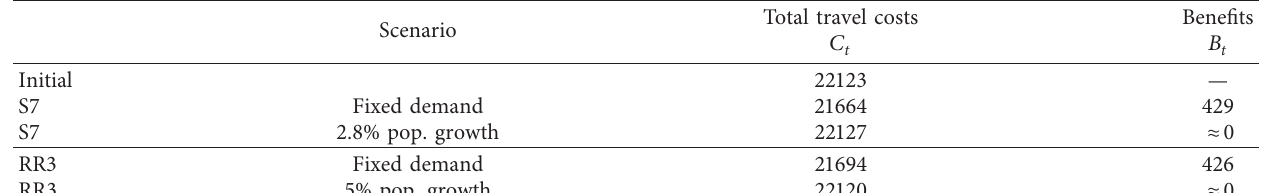
— — Table 3: Comparison of benefits of two alternative network improvements.